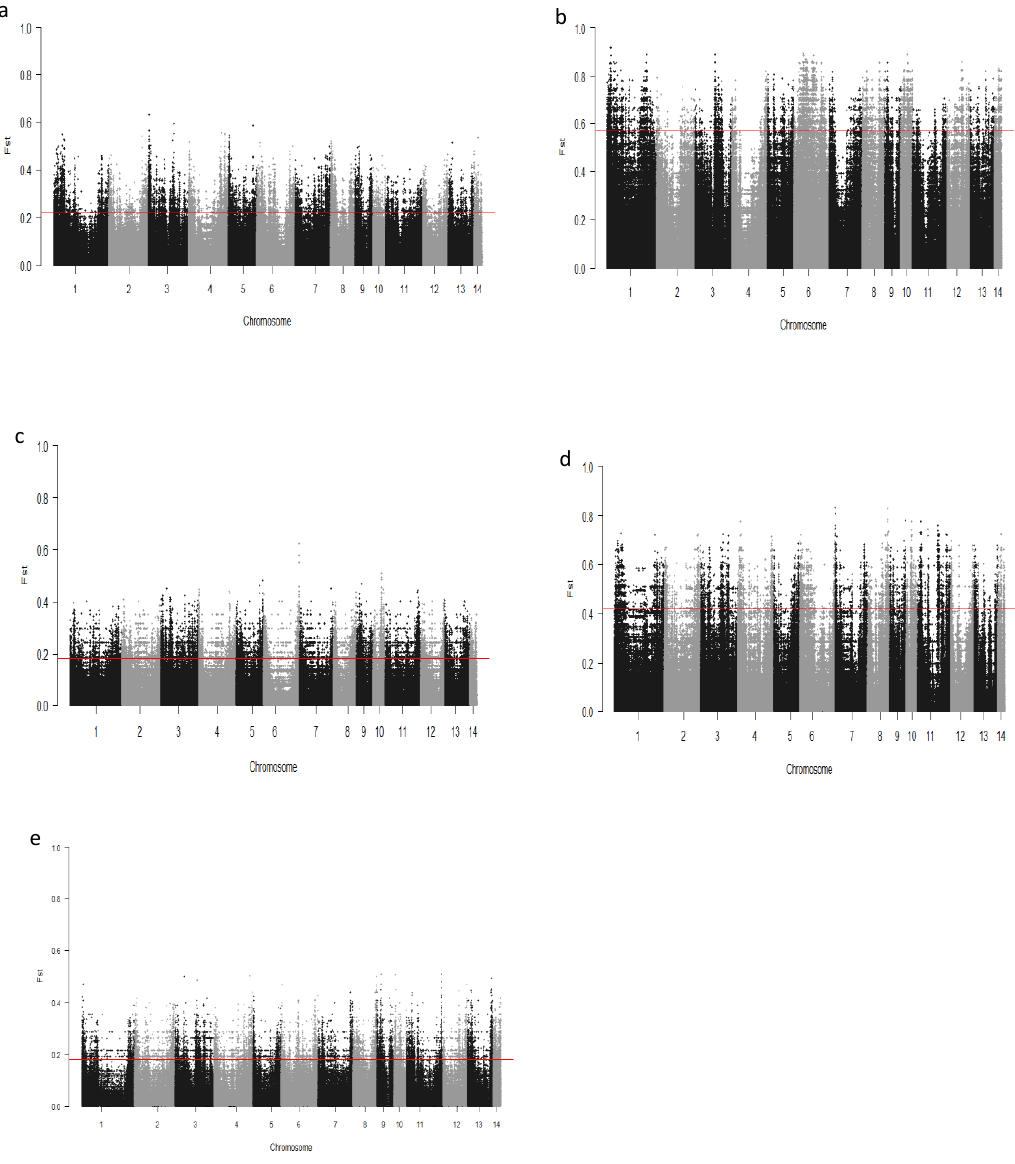
Figure 1. Genome-wide distribution of Fst across chromosomes in different groups of fur quality and coat color in American mink. The horizontal lines indicate the top 1% of values across the entire genome: Nap size ( a ), Overall fur quality ( b ), Skin size ( c ), Pastel_Balck ( d ), and Stardust_Black ( e